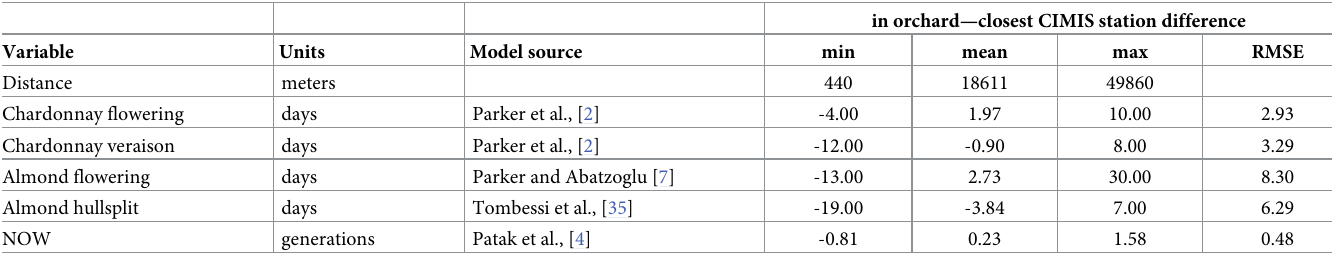
in orchard—closest CIMIS station difference